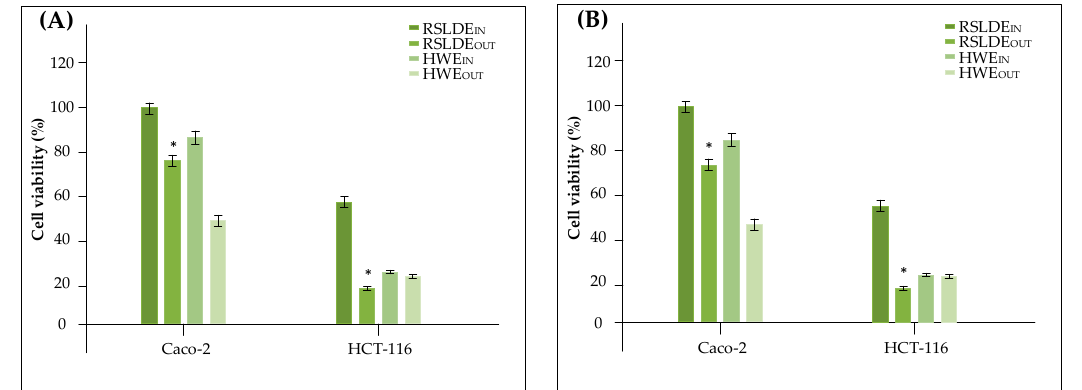
Figure 4. Comparison of proliferative activities on Caco ‐ 2 (non ‐ invasive) and HCT ‐ 116 (invasive) cell lines of the dialyzed extracts from hot water extraction (HWE IN and HWE OUT ) and rapid solid ‐ liquid dynamic extraction (RSLDE IN and RSLDE OUT ) after 24 ( A ) and 48 h( B ) exposure (* p < 0.05). RSLDE OUT was identified via GC ‐ MS as a mixture of glucose and mannitol (ratio 3.7:1), from the typical electron ionization (EI) patterns and from the retention times of authentic standards (Figure 5).